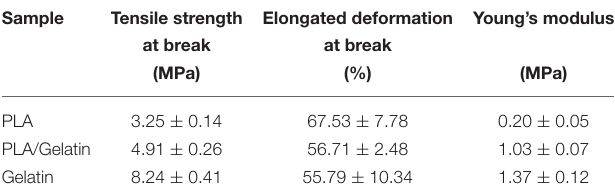
water contact angles on gelatin samples could not be measured. TABLE 2 | Stress/strain